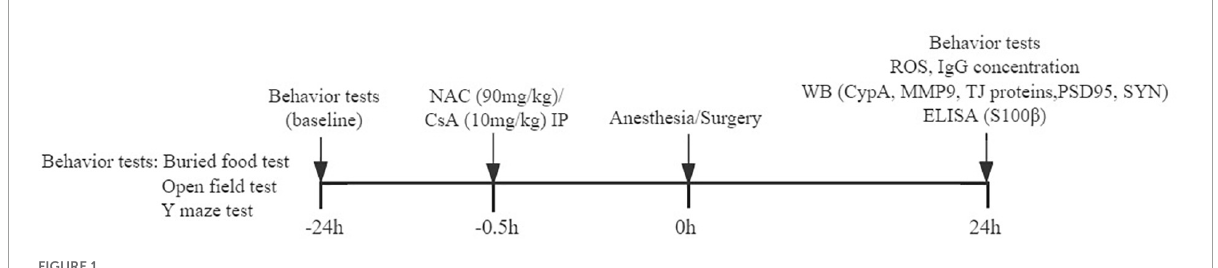
FIGURE1 Timeline diagram of experimental procedures. Behavioral tests are performed 24 h before and 24 h after anesthesia/surgery. NAC ( N -acetyl-cysteine) or CsA (Cyclosporin A) is injected intraperitoneally 0.5 h before anesthesia/surgery. ROS and IgG expressions in the prefrontal cortex; CypA, MMP9, TJ proteins, and PSD95, SYN levels in the prefrontal cortex; and S100 β concentration in serum are